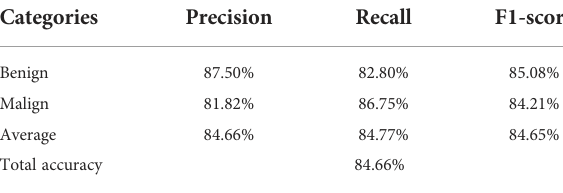
TABLE 3 Evaluation results of CAD on the balanced set.